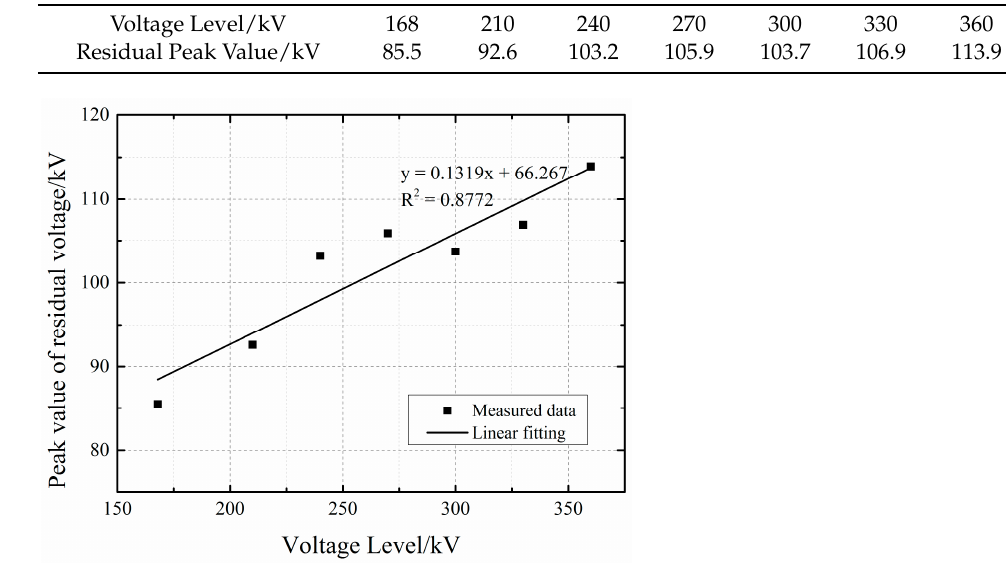
Table 3. The peak values of MOV residual voltage.